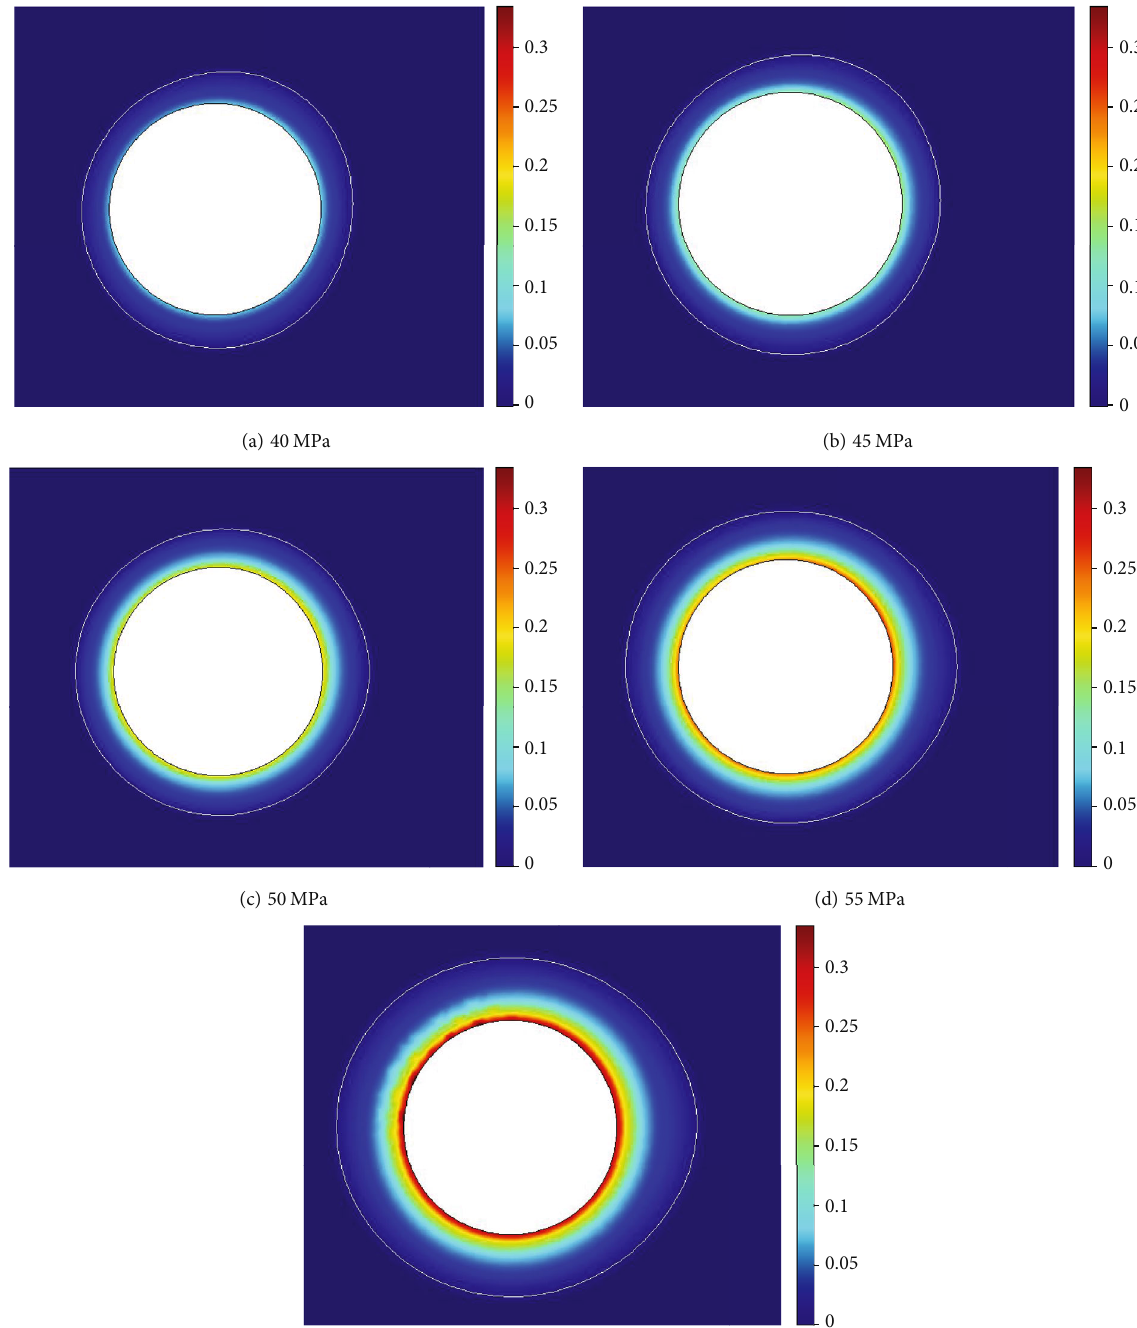
Figure 6: Damage of surrounding rock after excavation under di ff erent explosion